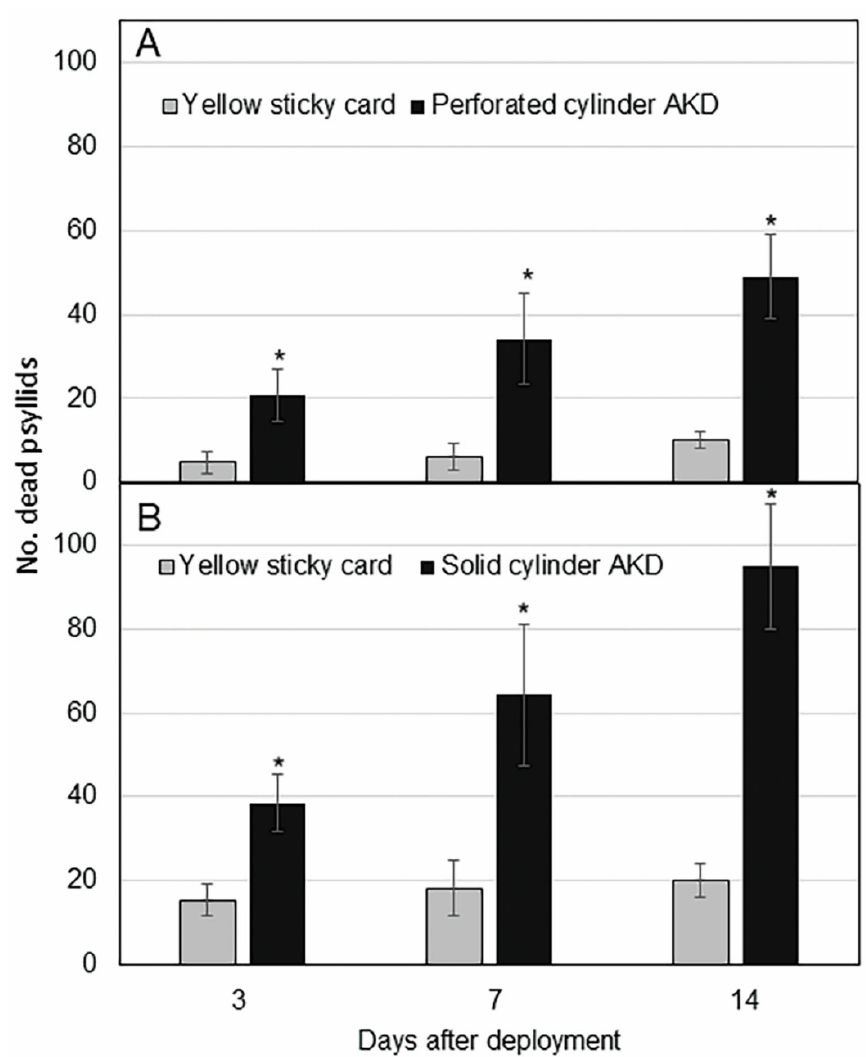
Figure 3. ( A ) Mean ( ± SEM, n = 6) number of Diaphorina citri adults attracted to and killed by perforated cylinder AK device compared to that captured on yellow sticky cards 3, 7, and 14 days after deployment. ( B ) Mean ( ± SEM, n = 6) number of Diaphorina citri adults attracted to and killed by solid cylinder AK device compared to that on yellow sticky cards 3, 7 and 14 days after deployment. Means labelled with asterisks are significantly greater than their paired control traps by paired t test (α = 0.05, n = 6).